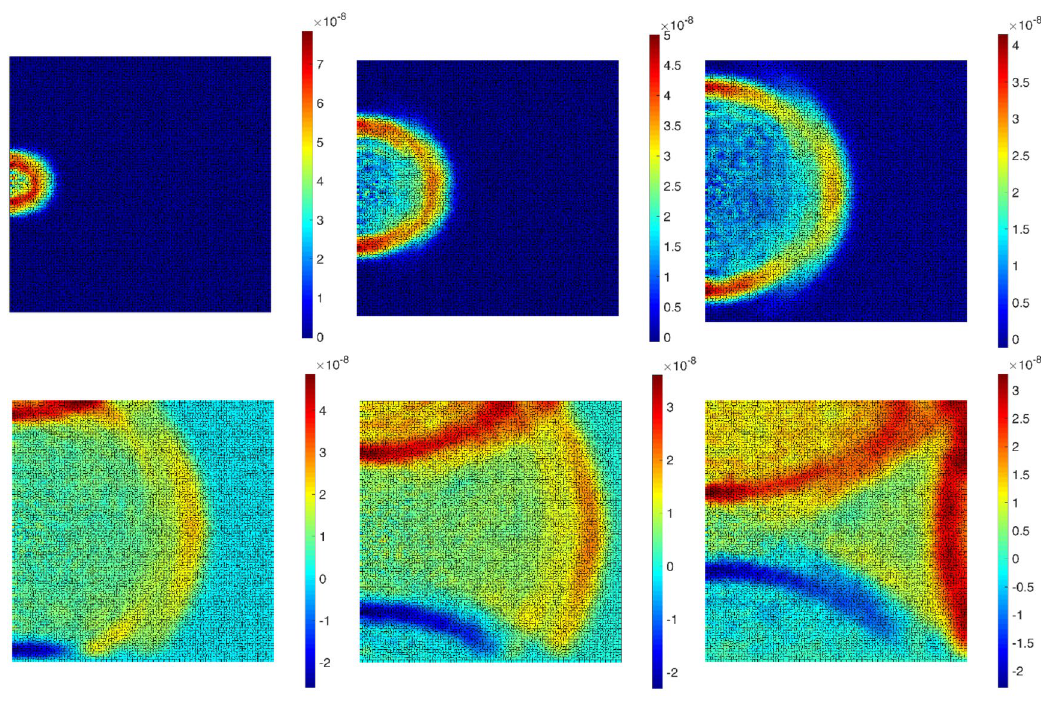
Figure 5. The 6 frames (100 time-steps interval, from left to right) of a displacement ( u x ) wave propagation inside the defined plate in Fig.